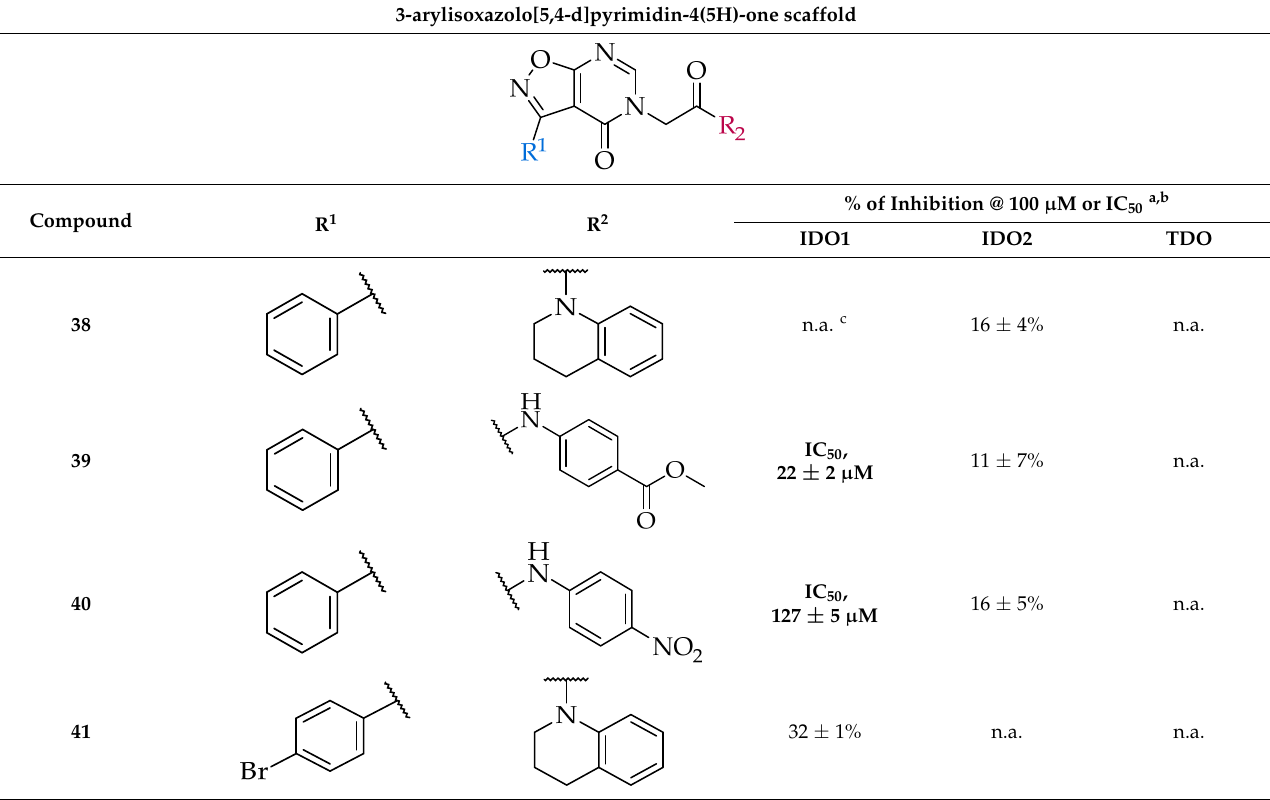
Table 2. Inhibitory potencies of synthesized compounds 38 – 53 with 3-arylisoxazolo[5,4- d ]pyrimidin-4(5 H )-one scaffold against IDO1, IDO2, and TDO.